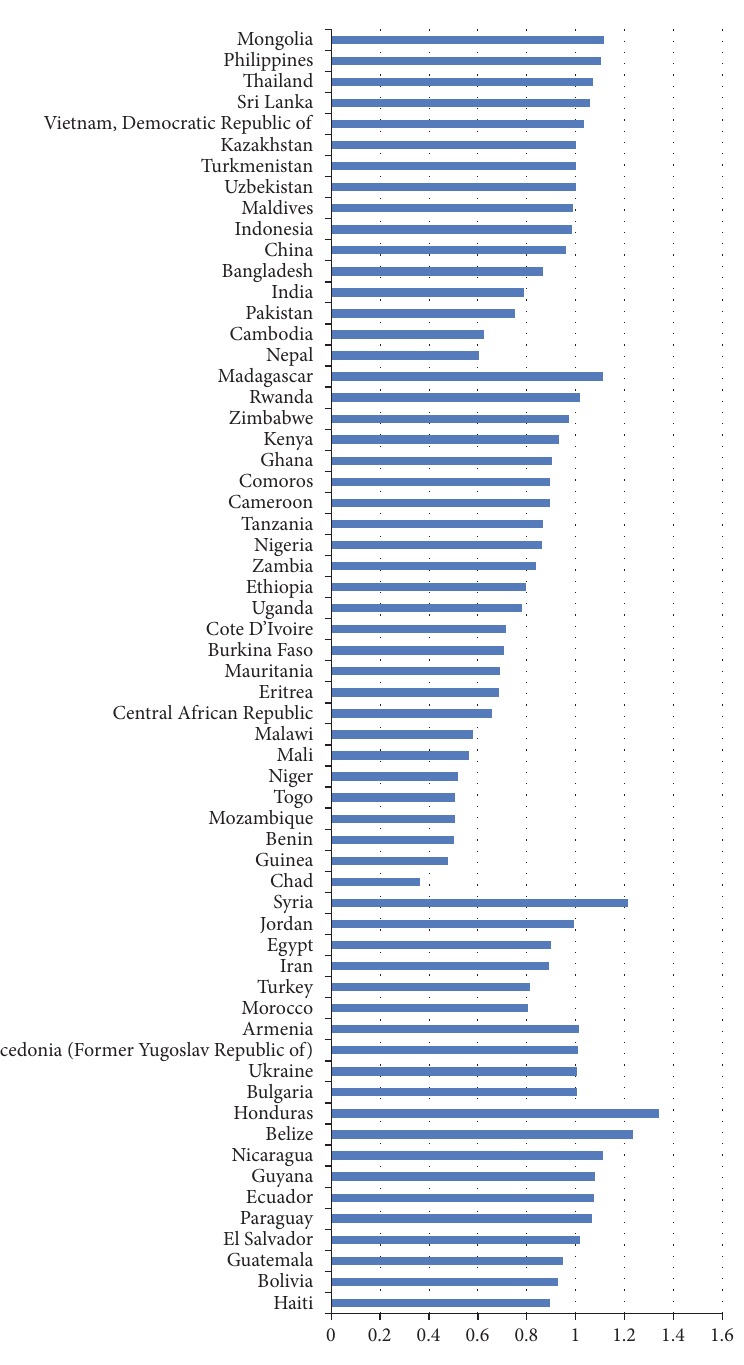
Figure 3: Developing countries: gender parity in secondary education by country,